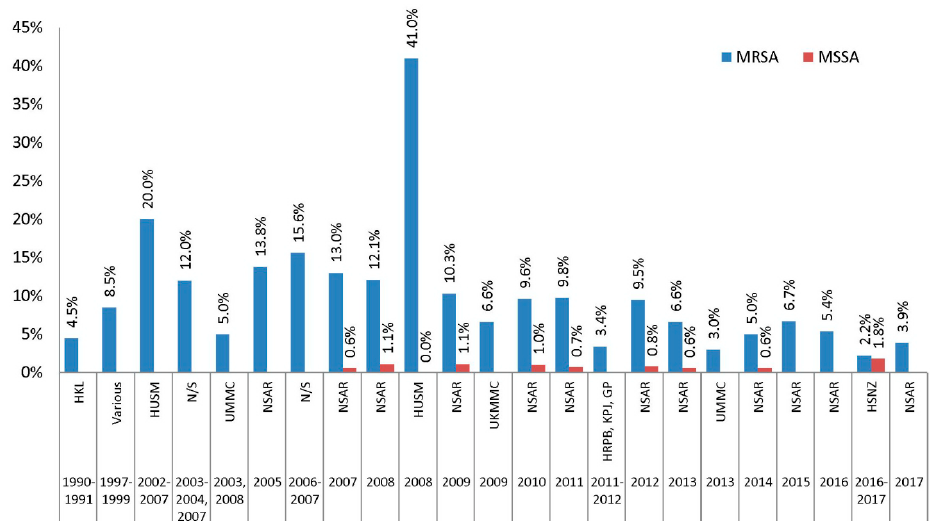
Figure 9. The prevalence of rifampin resistance in Malaysian S. aureus isolates, 1990–2017. Data from the NSAR reports; HKL between 1990 and 1991 [13]; various, collected from ten hospitals throughout Malaysia between 1997 and 1999 [14]; HUSM between 2002 and 2007 [15] and in 2008 [19]; not specified (N / S) between 2003 and 2004 and in 2007 [16], and between 2006 and 2007 [17]; UMMC in 2003 and 2008 [18], and in 2013 [22]; UKMMC in 2009 [20]; HRPB, KPJ and GP between 2011 and 2012 [21]; and HSNZ between 2016 and 2017